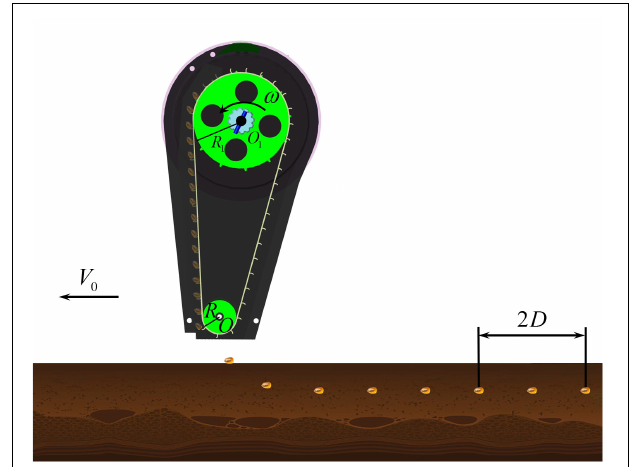
FIGURE 2 | Schematic diagram of smooth transport and delivery. D is the corn seed spacing, mm; V 0 is the working speed of the machines, mm/s; ω is the angular velocity of the seed metering shaft,